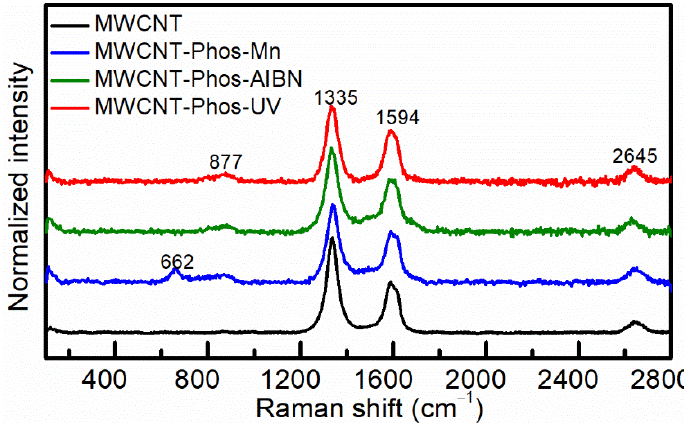
Figure 4. Raman spectra of pristine and functionalized MWCNTs. Table 2. Raman mode positions, linewidths (FWHM), and I D /I G ratios for MWCNT,